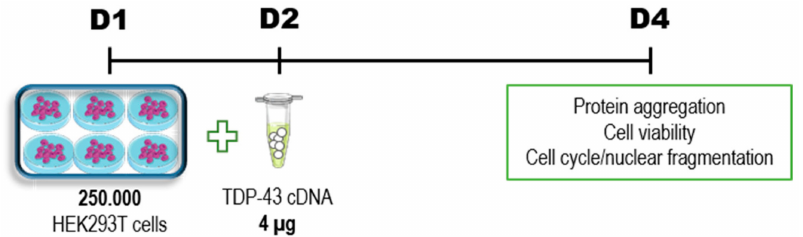
Figure 7. A fast, reproducible and reliable protocol for assessment of TDP-43-associated toxicity. Our protocol reveals the best markers of toxicity associated with TDP-43 overexpression: evaluation of protein aggregation (analyzed by western blot in di ff erential cell lysates), cell viability (by MTT reduction, LDH release, and PI incorporation), and cell cycle assessment (after cell lysis and PI incorporation). These parameters should be employed for the evaluation of possible therapeutic agents against TDP-43-mediated toxicity and possible application as ALS therapeutics.